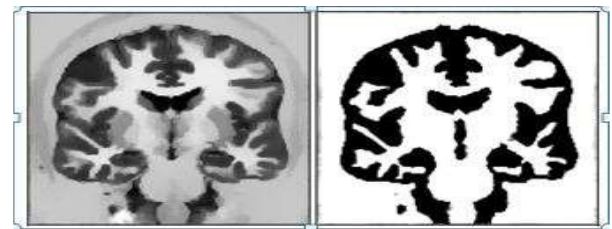
Figure 2. Segmentation of MR image by LBM